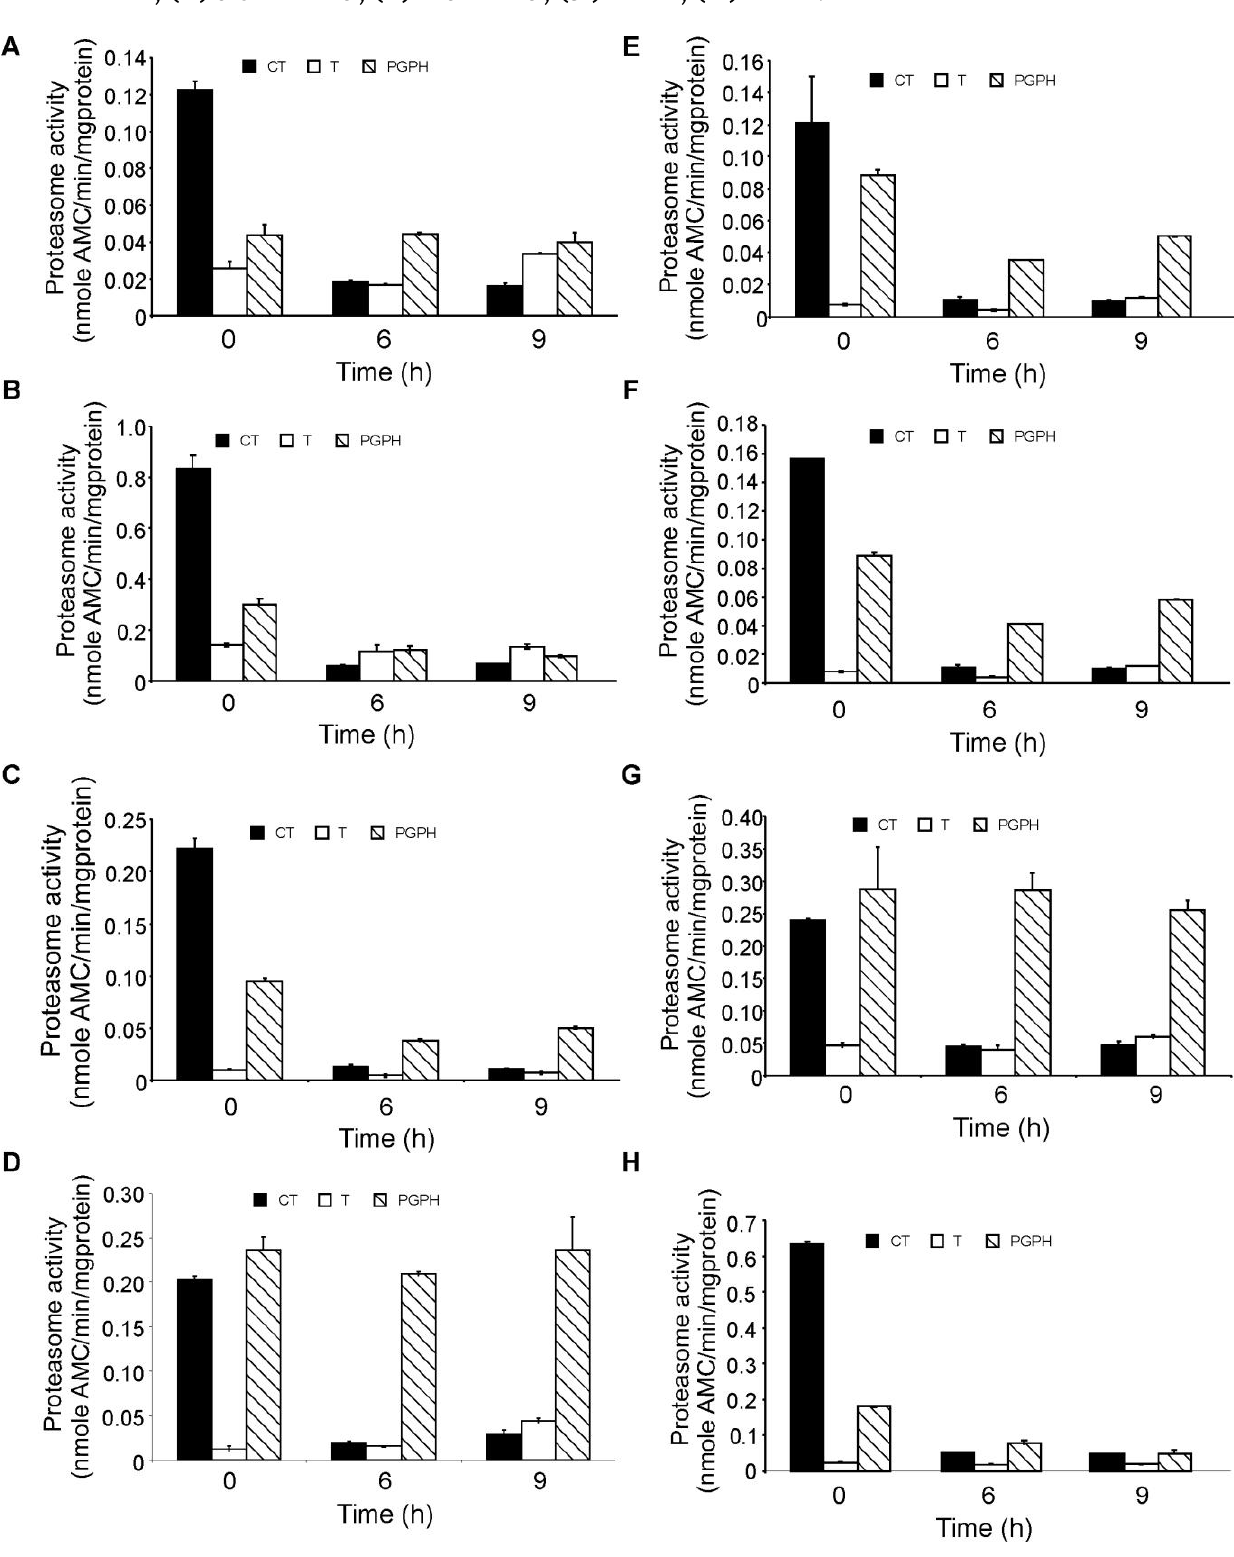
Figure 3. Bortezomib inhibits the chymotryptic activity of the proteasome. AML cells were treated with 100 nM bortezomib for 6, 9 or 18 h. Chymotryptic-like (CT), tryptic-like (T) and PGPH-like proteasomal activity was measured as described in the experimental section Proteasome activity is expressed as nmoles substrate (AMC) cleaved per 1 mg cellular protein in one minute ± S.E.M. ( A ) HL-60; ( B ) KG-1; ( C ) Kasumi; ( D ) OCI AML2; ( E ) OCI AML3; ( F ) MOLM13; ( G ) ML-2; ( H )